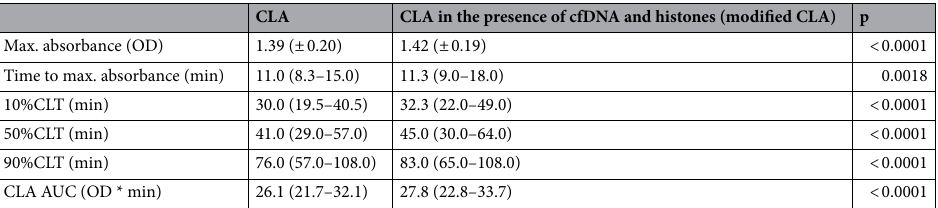
Table 4. Admission clot lysis assay (CLA) parameters in the absence or presence of cell-free DNA (cfDNA) and histones in the total cohort. Data are means ± SD or medians (interquartile ranges). cfDNA, cell-free DNA;